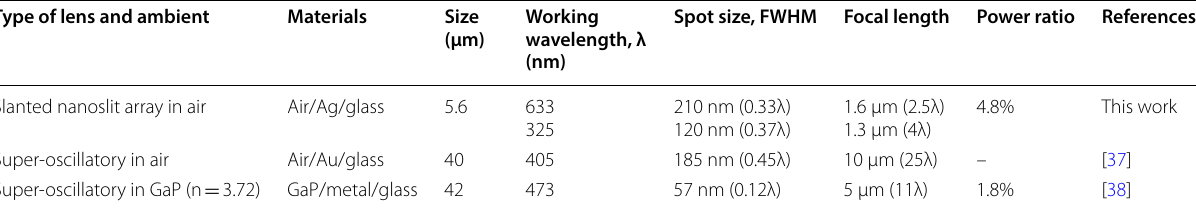
Table 1 Comparison of a slanted nanoslit array lens with superoscillatory lenses: sub‑Abbe‑limit beam focusing at far‑